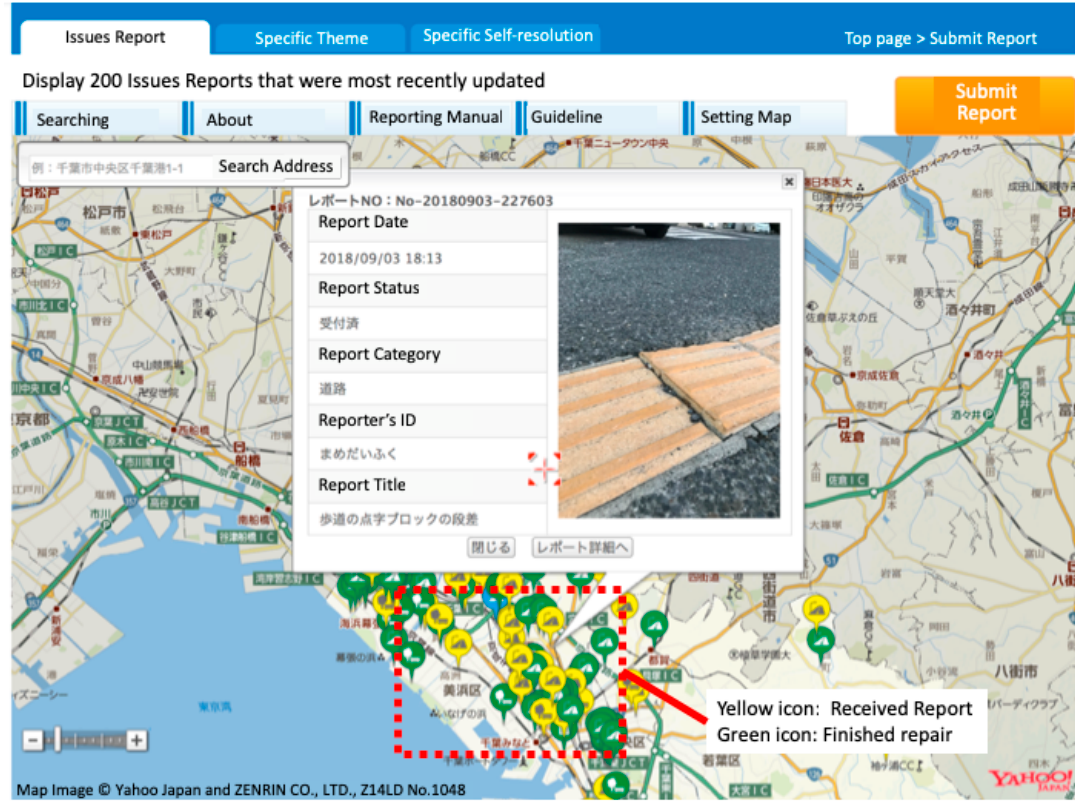
Figure 1. The web interface of Chiba-repo. Image source: